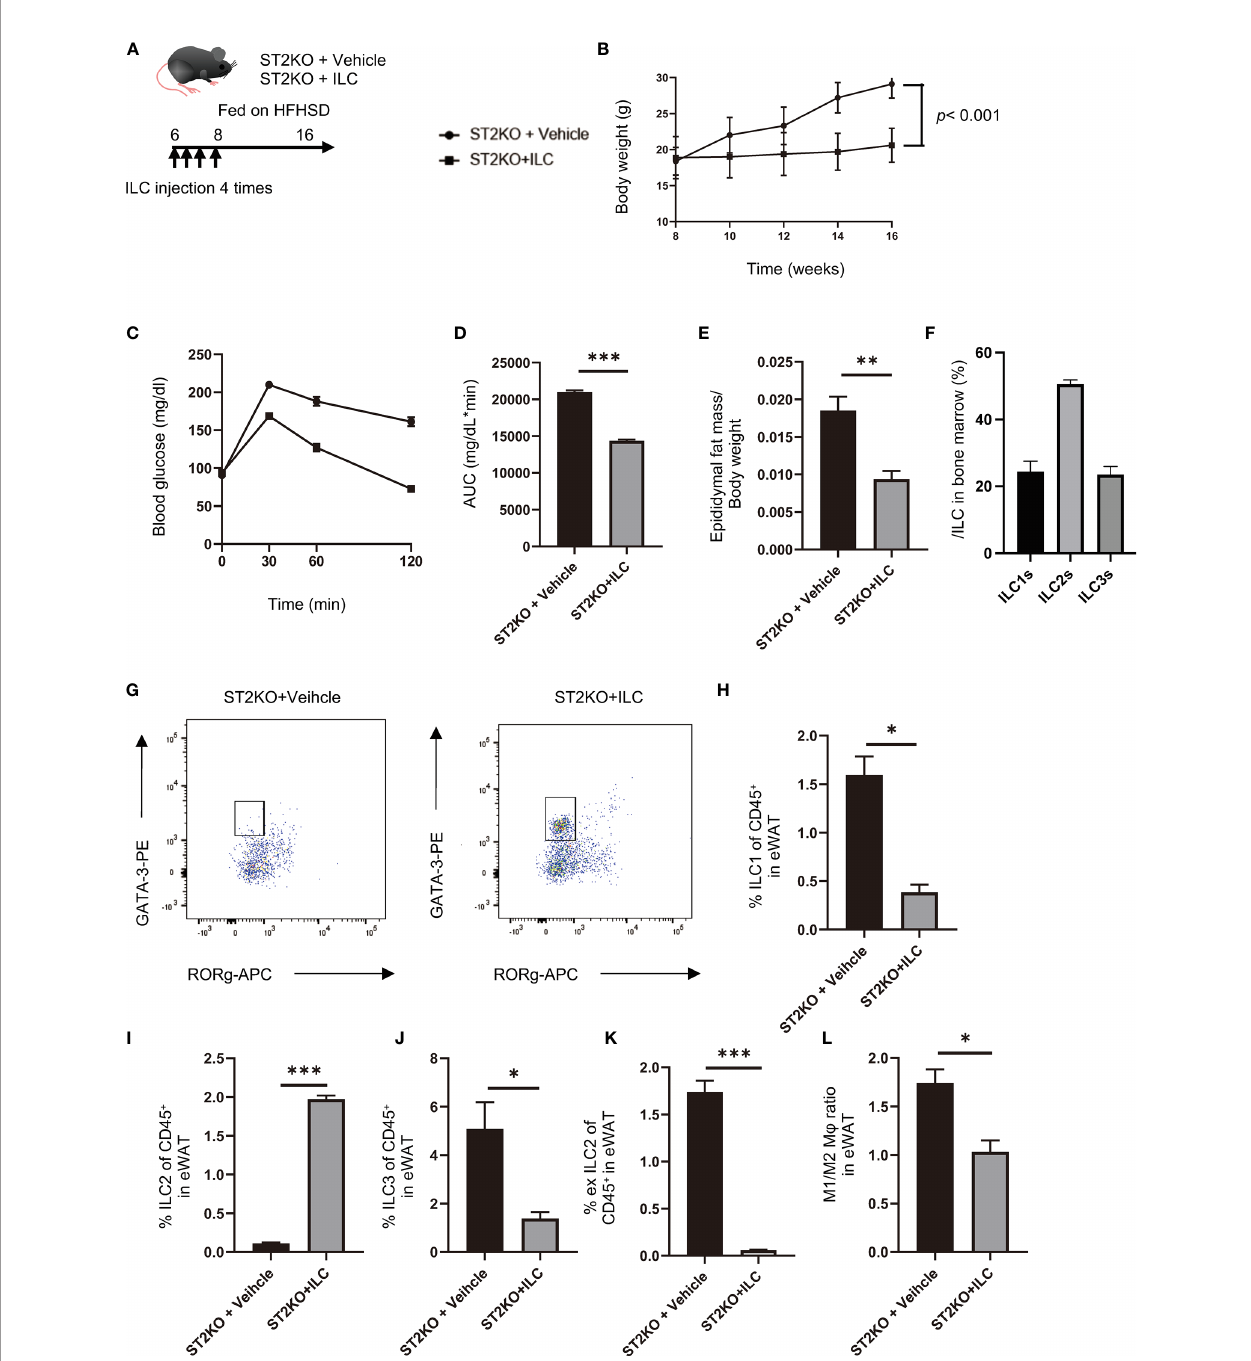
FIGURE 5 | Adoptive transfer of ILCs from WT mice bone marrow improved glucose tolerance in ST2KO mice. (A) The adoptive transfer was performed four times within two weeks from the fi rst injection into 6-week old mice. The total number of ILCs injected into ST2KO mice was 8 – 10 × 10 5 cells/mouse/experiment. The 8- week old mice were placed on a HFHSD on the last day that ILCs were transferred. (B) Body weight changes (n = 6) are shown. (C, D) When the mice reached 20 weeks of age, an intraperitoneal glucose tolerance test (iPGTT) (2 g/kg body weight) was performed, and the data ’ s area under the curve (AUC) was analyzed (n = 6). (E) The ratio of epididymal fat mass to body weight (n = 6) is shown. (F) The ratio of ILCs in bone marrow is shown (n = 6). (G) Representative fl ow cytometry plots of epididymal white adipose tissue (eWAT) CD45+ Live and Dead-Lin-CD127+ RORg-GATA-3+ ILC2s at 20 weeks of age. (H) The ratio of ILC1s to CD45 positive cells in eWAT (n = 6). (I) The ratio of ILC2s to CD45-positive cells in eWAT (n = 6). (J) The ratio of ILC3s to CD45-positive cells in eWAT (n = 6). (K) The ratio of ex-ILC2s to CD45-positive cells in eWAT (n = 6). (L) The ratio of M1 macrophages in M2 macrophages in eWAT (n = 6). Data are represented as mean±SD; *p < 0.05, **p < 0.01, ***p < 0.001 by one-way ANOVA